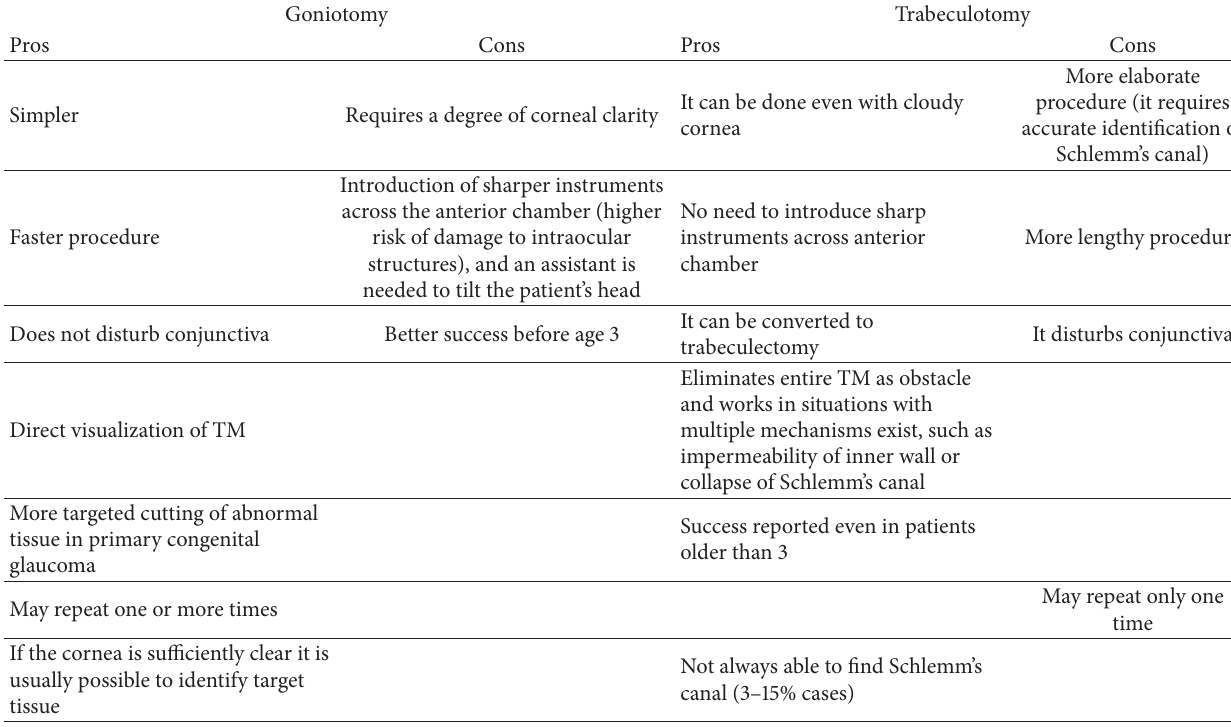
Table 1: Summary of the advantages and disadvantages for either